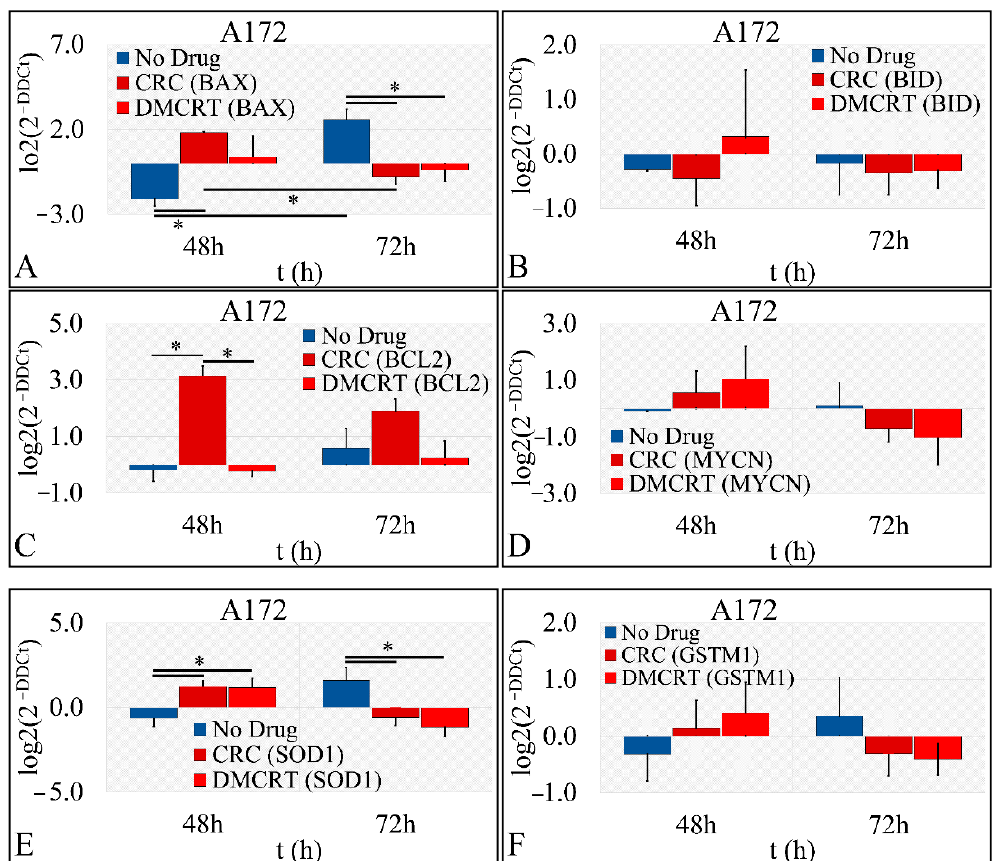
Figure 6. Gene expression under CRCs and DMCRT treatment. We performed indicative gene expression experiments for cells treated with CRCs and DMCRT. In particular, we investigated and compared to CRCs’ gene expression, gene expression for BAX ( A ), BID ( B ), BCL2 ( C ), MYCN ( D ), SOD1 ( E ) and GSTM1 ( F ) (the asterisks depict a significance at p < 0.05 level).